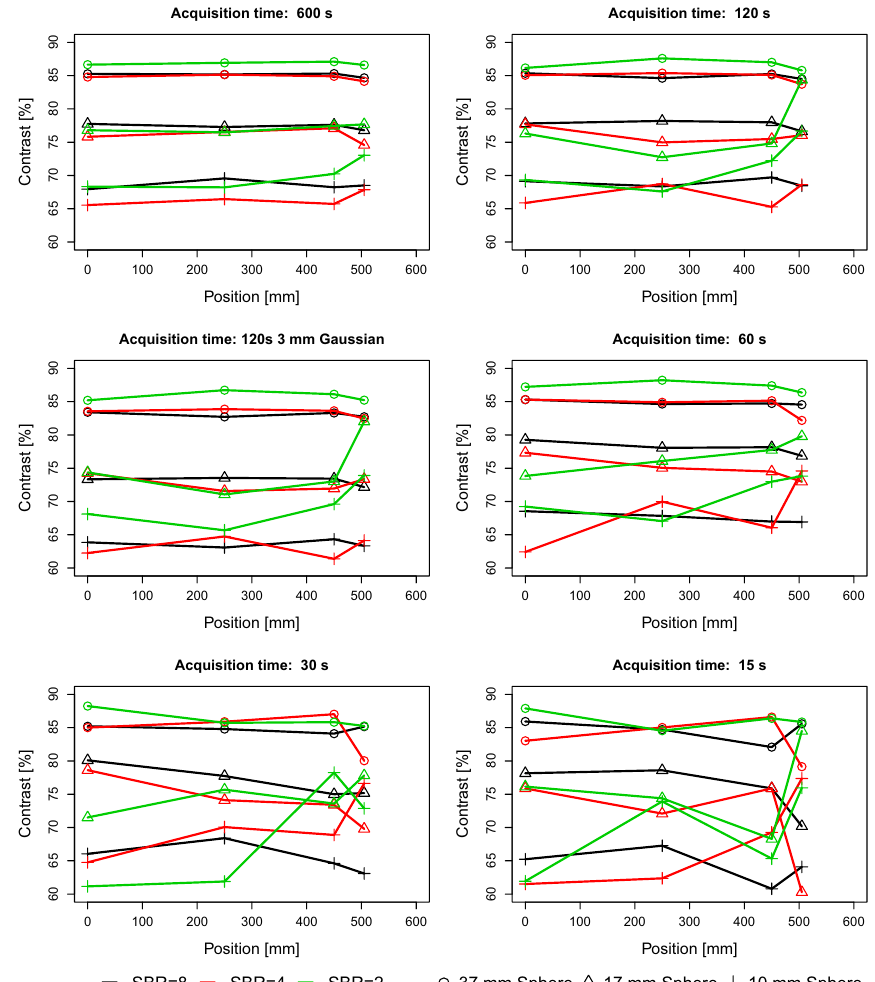
Fig. 5 Image contrasts for three representative sphere sizes for the different SBRs and axial